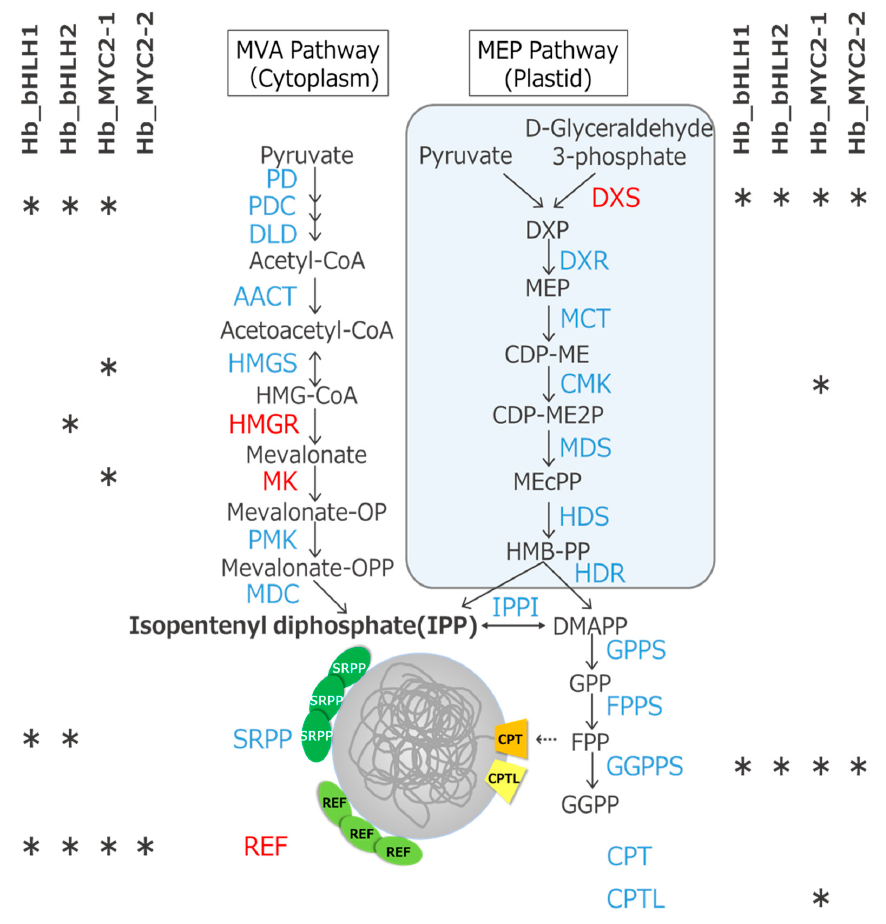
Figure 5. Candidate genes targeted by four bHLH-type TFs in the MVA, MEP, and rubber biosynthetic pathways. Asterisks indicate candidate genes. The family names (DXS, HMGR, MK, and REF) that include upregulated genes upon MeJA treatment are presented by red color. DXS8 (Hb_012796_050), HMGR5 (Hb_000116_530), and MK3 (Hb_002042_080) and REF7 (Hb_001741_110) were upregulated at 4 h, 24 h, and 5 d after MeJA treatment, respectively. Downregulated genes upon MeJA treatment were not found in these gene families.